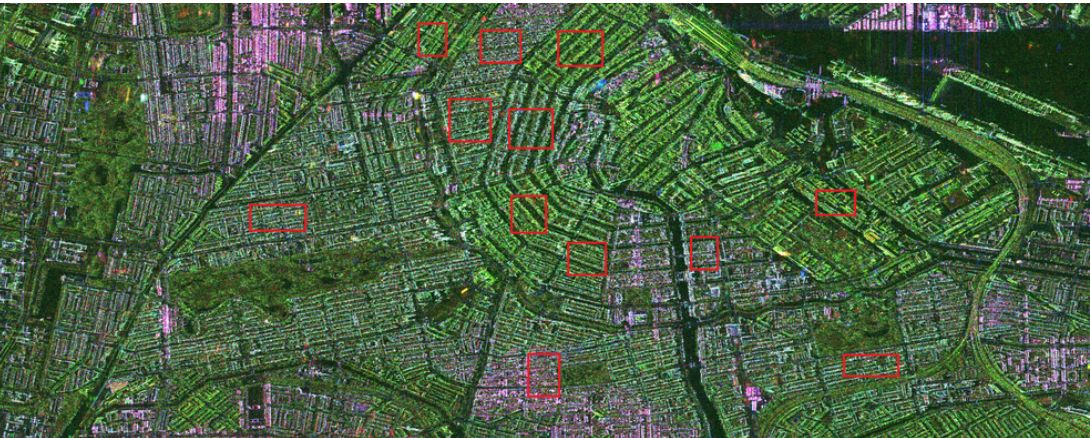
Figure 8. PolSAR image of Amsterdam acquired by TerraSAR-X (X-band)in the Pauli basis. The sensor trajectory is parallel to the left side of the figure. Red rectangles refer to selected